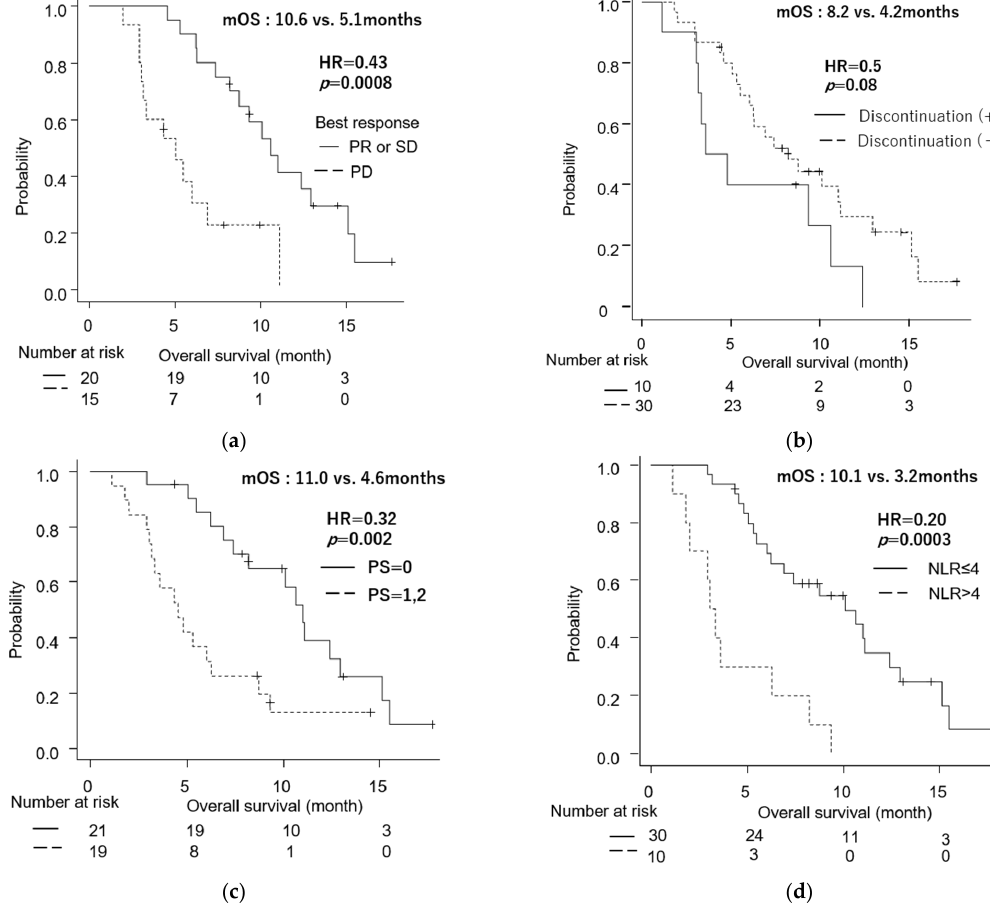
Figure 2. Kaplan–Meier survival analyses. ( a ) Overall survival (OS) with the best response = progressive disease (PD) versus stable disease (SD) or partial response (PR). ( b ) OS with treatment discontinuation versus without discontinuation. ( c ) OS with performance status (PS) = 0 versus PS = 1, 2. ( d ) OS with neutrophil-lymphocyte ratio (NLR) > 4 versus NLR ≤ 4. mOS, median overall survival; HR, hazard ratio. p -value was calculated using the log-rank